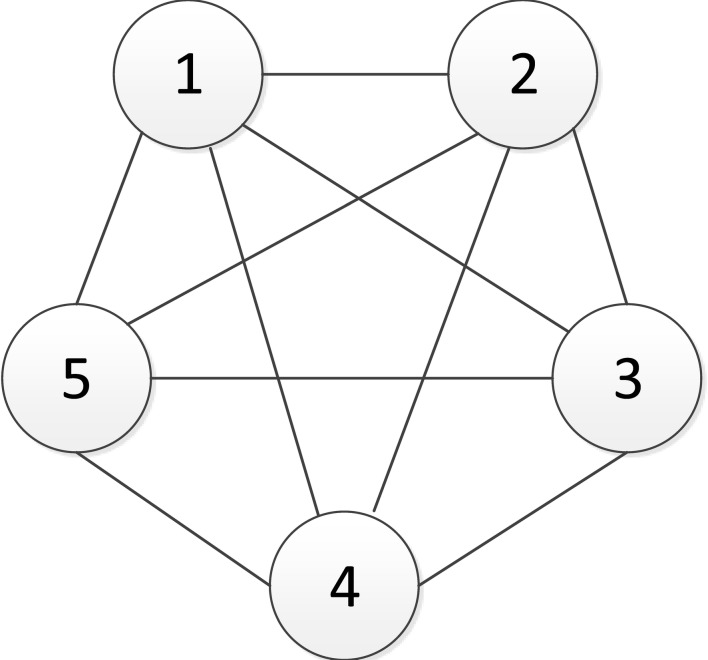
The network diagram of the first five firms of G2001.